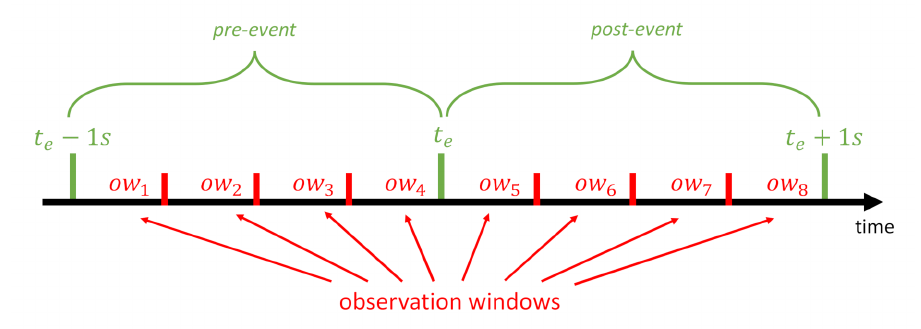
Figure 1. Representation of a generic